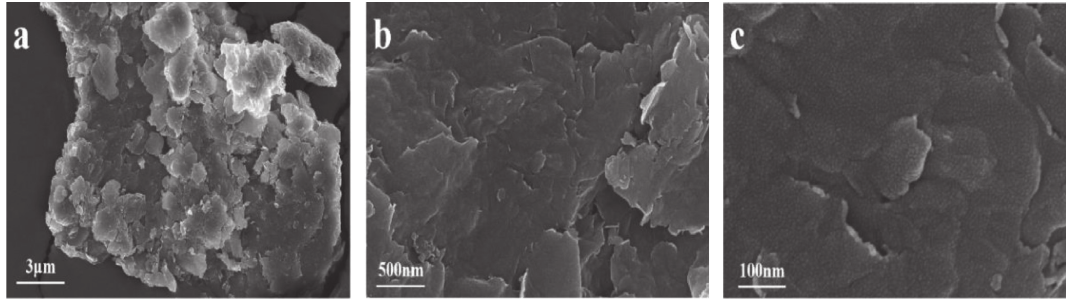
Figure 5: SEM images of the OMMT: (a) 3 μ m, (b) 500nm, and (c) 100nm scale bar.